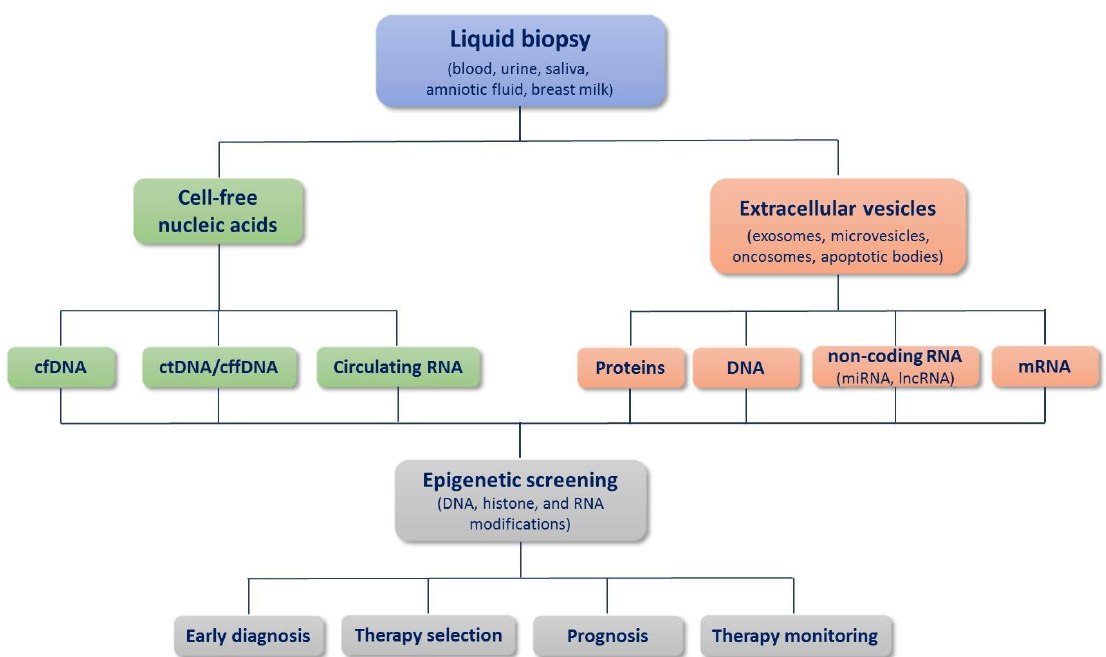
Figure 1. A diagram showing the potential utility of liquid biopsy highlighting cell-free nucleic acids and extracellular vesicles. These may undergo diverse epigenetic alterations that may have diagnostic, predictive, and prognostic values. cfDNA, cell-free DNA; ctDNA, cell-free tumor DNA; cffDNA, cell-free fetal DNA; miRNA, microRNA; lncRNA, long non-coding RNA.